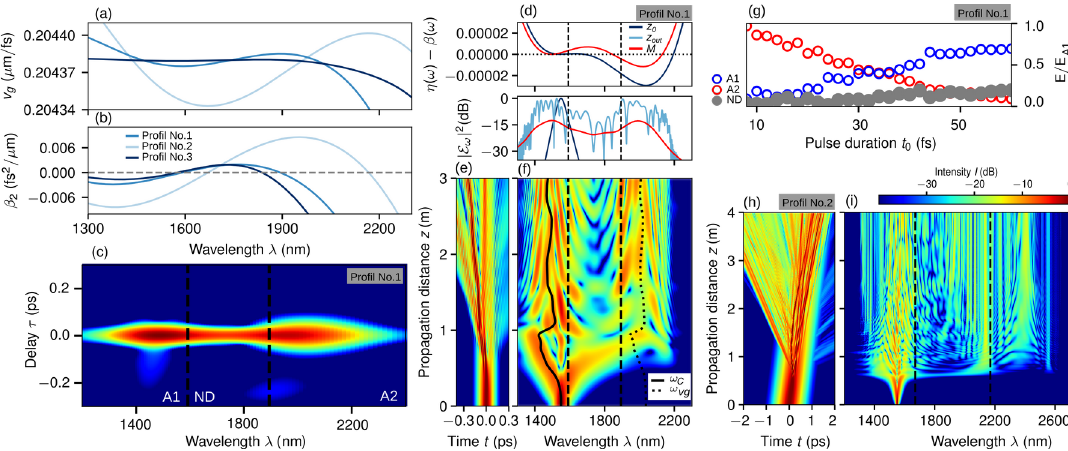
Fig. 1 Self-generation scheme. (a,b) Group-velocity and group-velocity dispersion. (c) Spectrogram of generated compound state. (d) Phase-matching analysis (top) and spectrum (bottom) of input, output, and filtered compound state denoted by dark blue, light blue, and red line, respectively. Propagation dynamics of self-generation process in temporal (e) and spectral (f) domain. (g) Parameter study for initial pulse durations. Supercontinuum generation in temporal (h) and spectral (i)